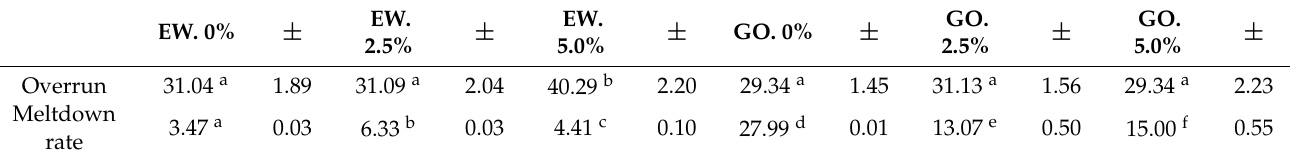
Table 5. Overrun and meltdown rate of ewe’s and goat’s frozen yoghurts immediately after production ( n = 3). EW. 0%